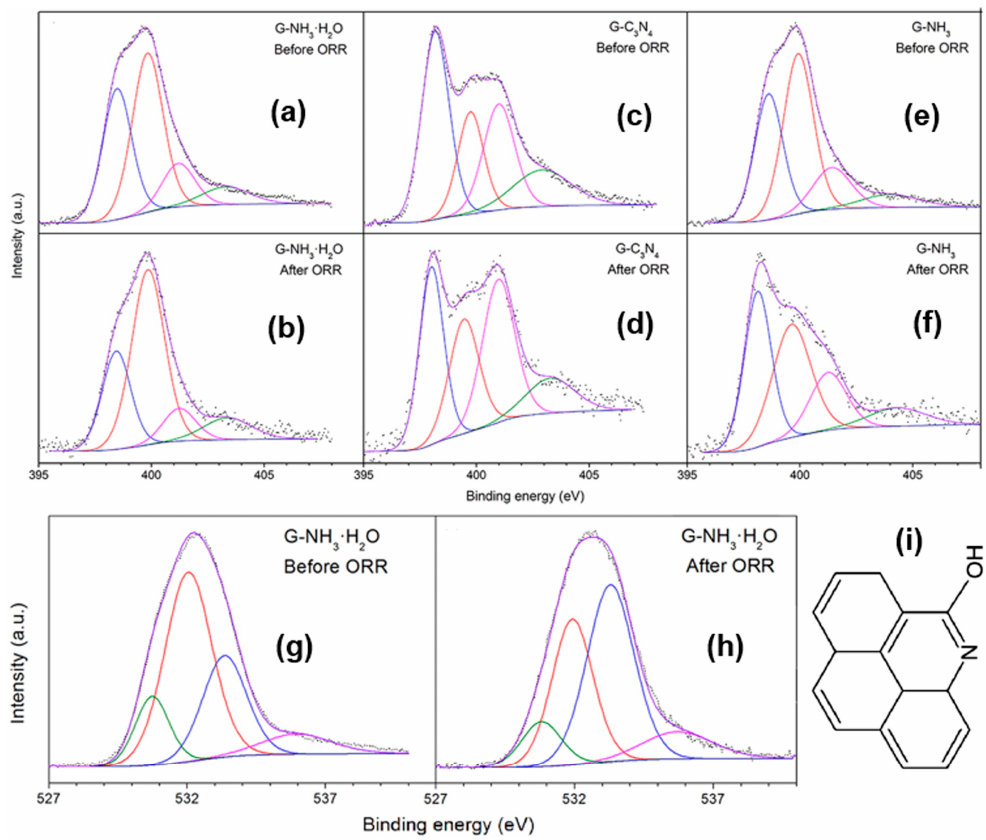
Figure 9. ( a – f ) The corresponding high-resolution XPS N1s spectra of the three multilayer graphene samples obtained before and after ORR. The least-squares fitted peaks are pyrrolic N at 399.8 eV (red), graphitic N at 401.2 eV (purple), pyridinic N at 398.5 eV (blue), and nitrogen oxide at 403 eV (green). XPS O1s spectra of G-NH 3 · H 2 O obtained ( g ) before and ( h ) after ORR. The fitted peaks are C=O at 530.8 eV (green), C(aliphatic)–OH/C(aliphatic)–O–C(aliphatic) at 532.0 eV (red), C(aromatic)–OH at 533.3 eV (blue), and chemisorbed water molecules at 535.7 eV (purple). ( i ) Diagram of the chemical structure of − OH attached to the pyridinic N. Reprinted with permission from Ref. [40] 2014 American Chemical Society.